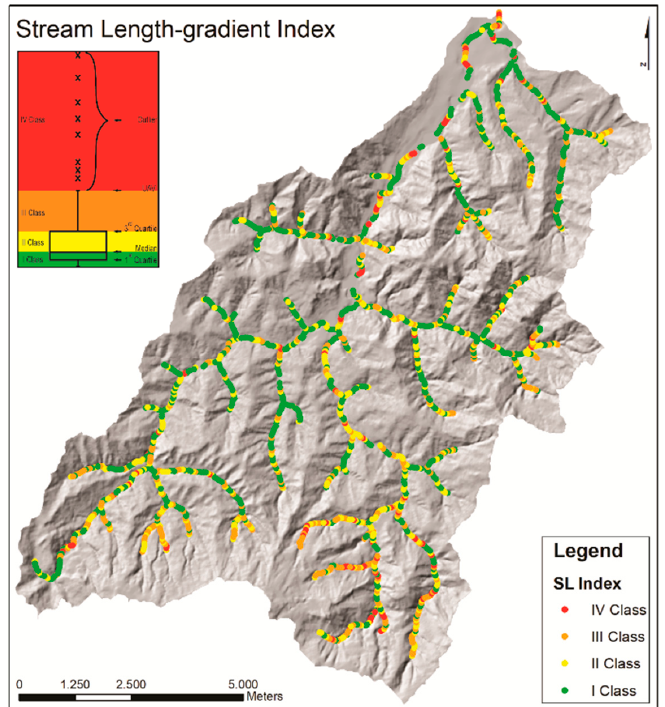
Figure 4. Stream length-gradient index map obtained using the SLiX tool and applying a four classes classification based on quartile values.